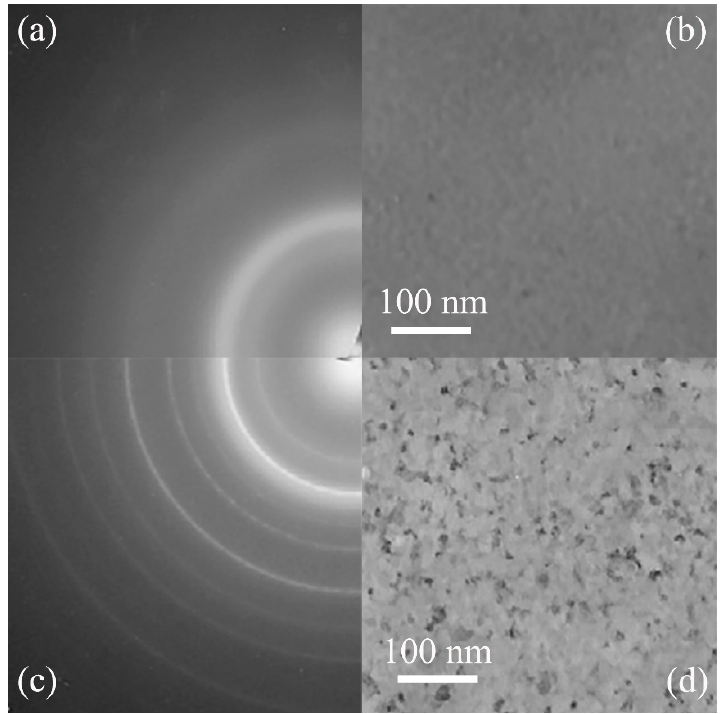
Figure 8. The SAD patterns and corresponding bright field image of the ( a , b ) (NiZr) 60 Mo 40 and ( c , d ) (NiZr) 40 Mo 60 nano-multiple-metal-layers [72] after irradiation with a dose of 7 × 10 15 Xe + /cm 2 .